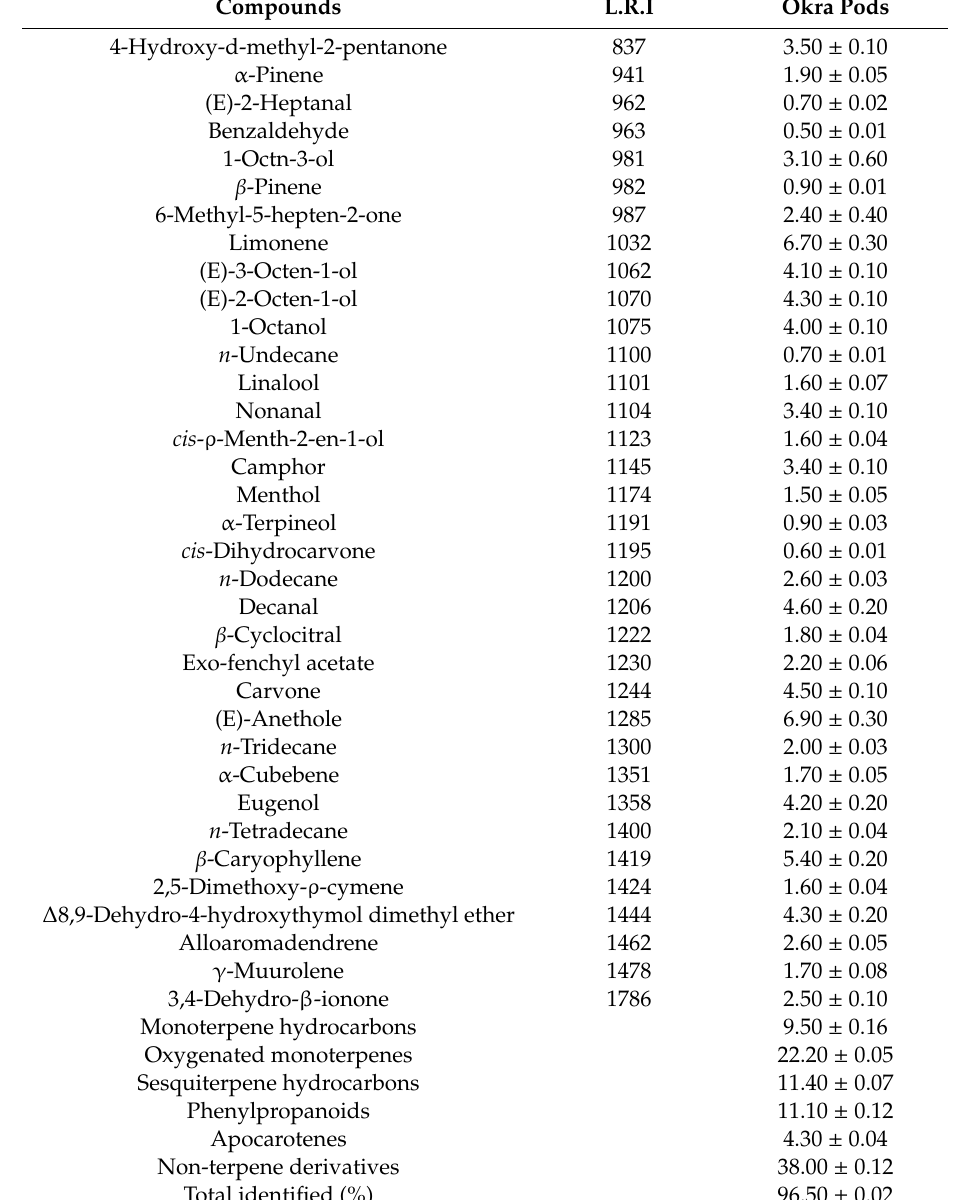
Table 3. Volatile compounds (%) identified in okra